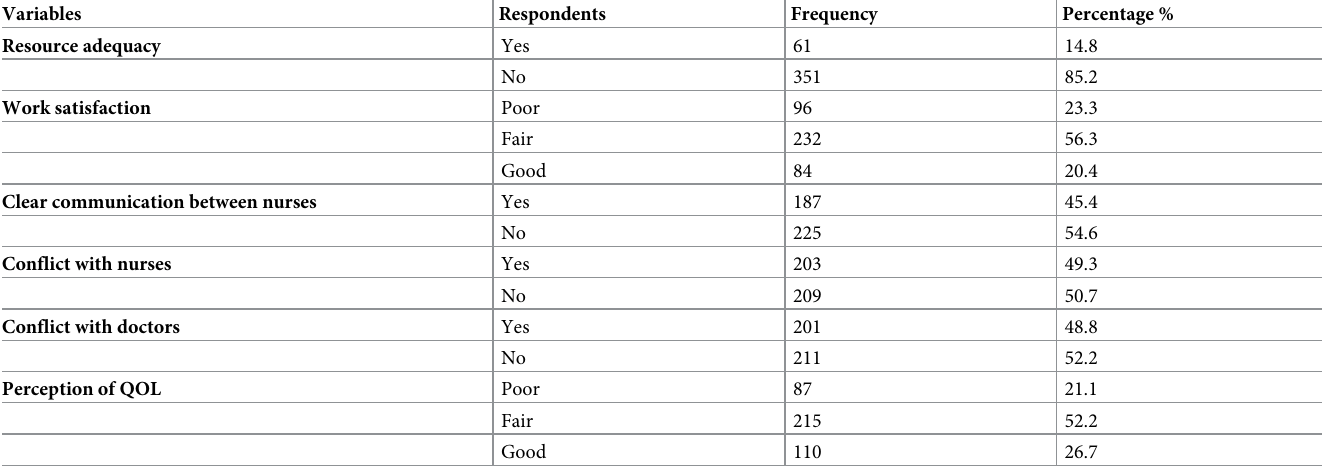
Table 3. Characteristics of organizational and managerial factors of Harari regional state and Dire Dawa administration, Ethiopia, 2020 (n = 412). Variables Respondents Resource adequacy Work satisfaction